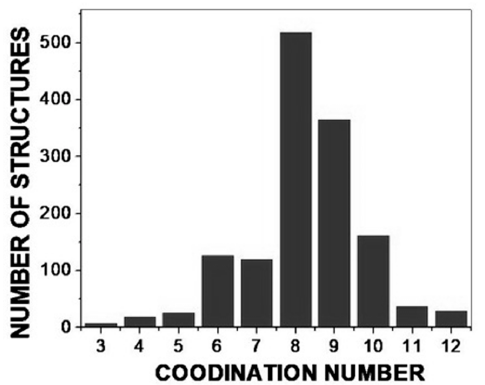
Figure 4. Abundance of coordination numbers in Ln-complexes (La–Nd, Sm–Lu, Y) based on the analysis of 1389 crystal structures published between 1935 and 1995. The figure and captions were reproduced from Reference [24] with permission from the Elsevier Ltd.